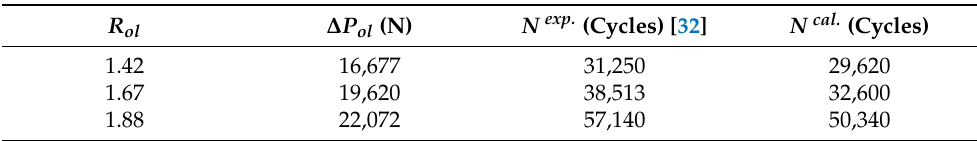
Table 1. Evaluated number of loading cycles and applied force ranges with corresponding stress ratios under overloading. R ol ∆ P ol (N) N exp. (Cycles) [32] N cal.